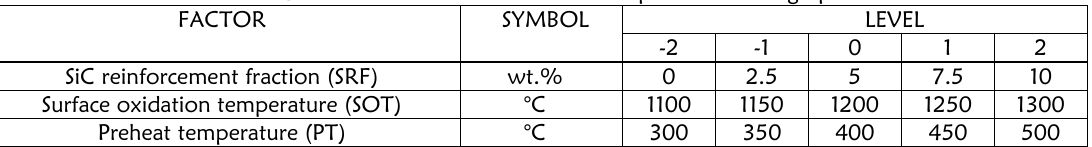
Table 3: Factors and levels for the CCD experimental design